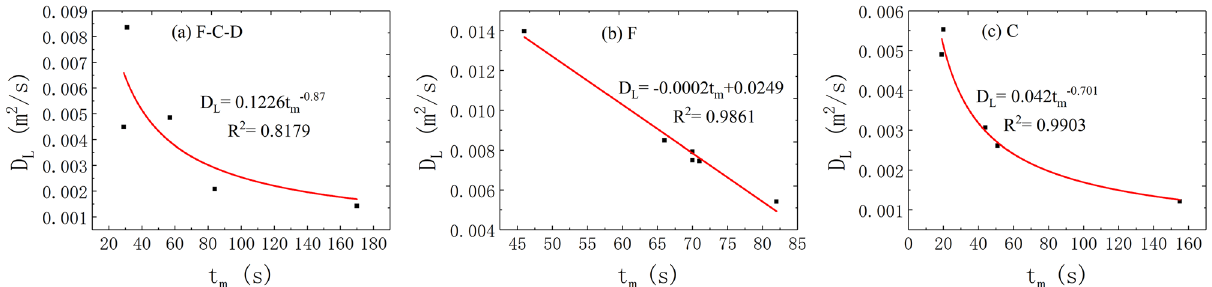
Figure 9. The correlation between the t m and D L in different flow condition.